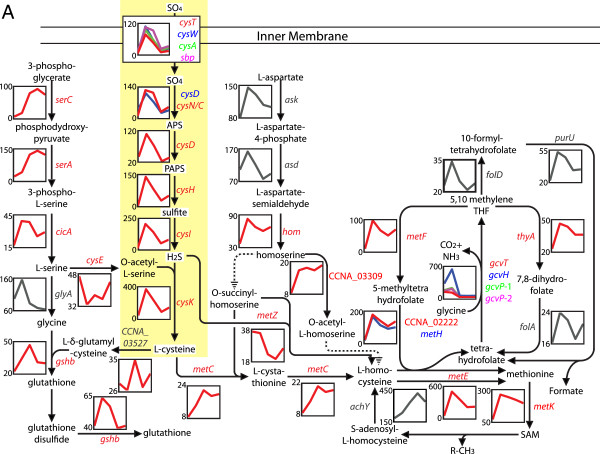
Correlated cell cycle expression of the sulfur metabolic network. (A) Every reaction performed by a predicted enzyme has the gene name and mRNA expression profile flanking the reaction arrow. Dotted arrows indicate that no C. crescentus gene has been predicted to perform this specified reaction. The color of protein names corresponds to the color of the expression profile. Protein and expression profiles in grey indicate that they were not identified as cell cycle-regulated because of the variance between biological replicates. Genes in yellow box are major contributors of the magenta module (see Figure 6B) and are involved in sulfur import and assimilation to cysteine. The expression data used to build the cell cycle profiles are provided in Additional file 3: Table S1b.